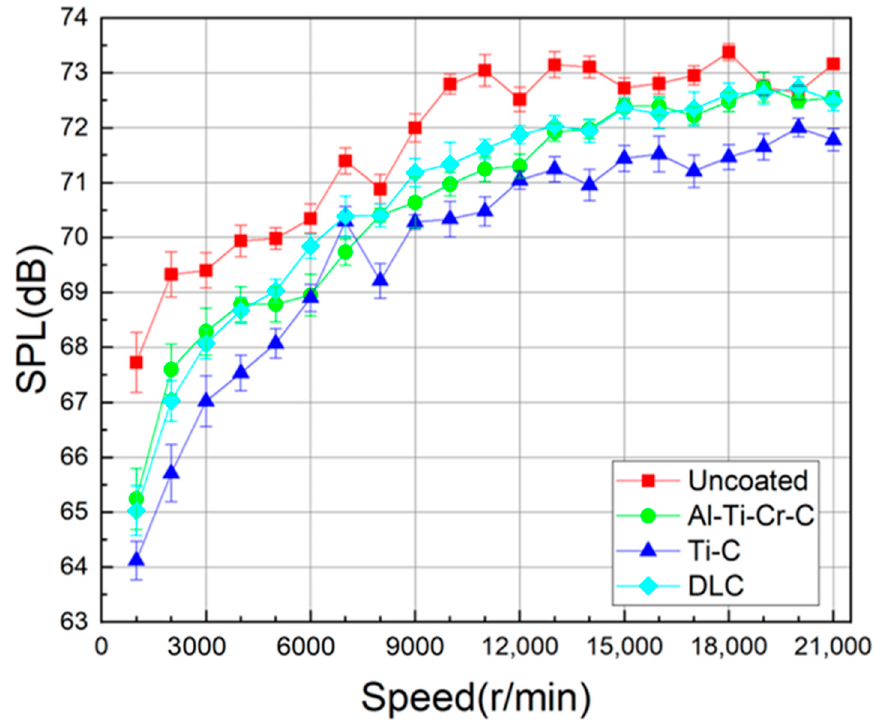
Figure 10. Average sound pressure level of the spindle–speed graph.